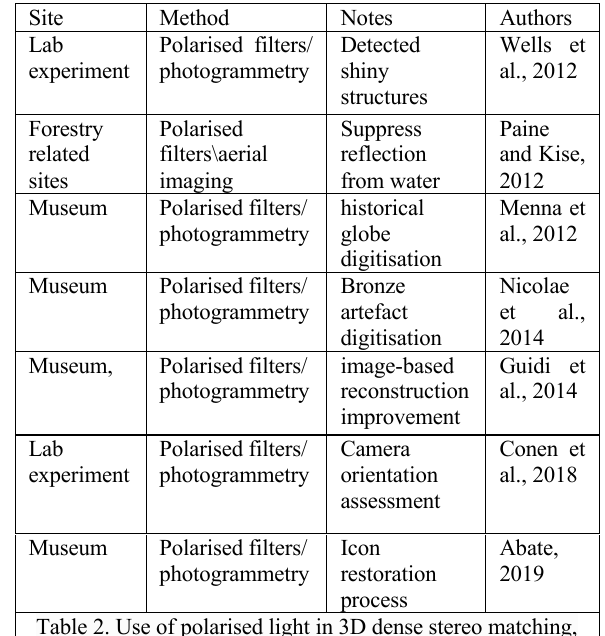
Table 2. Use of polarised light in 3D dense stereo